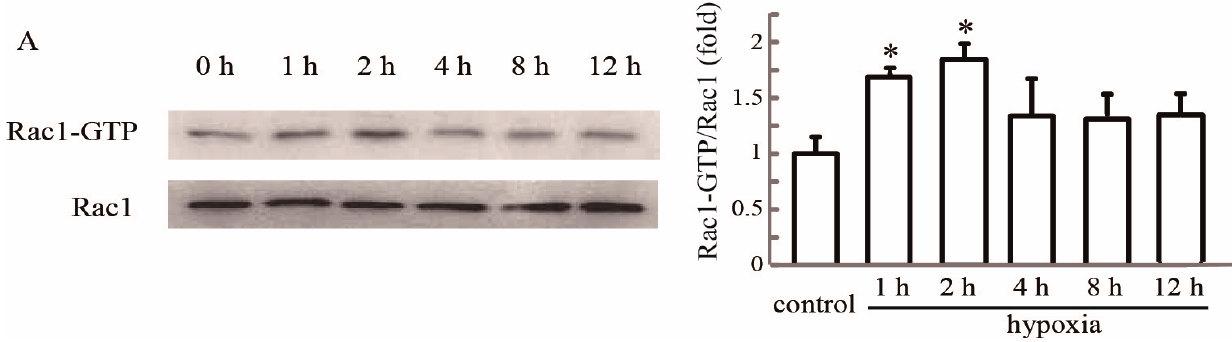
Figure 2. Melatonin inhibits hypoxia-induced Rac1 activation. ( A ) The effect of hypoxia on Rac1 activation. HUVECs were incubated under normoxia or hypoxia for the indicated periods, and cellular lysates were assayed for active Rac1 by pull-down assay; ( B , C ) The effect of melatonin on hypoxia-induced Rac1 activation. After treatment with melatonin at the indicated concentrations, cells were exposed to hypoxia for 2 h and then analyzed for Rac1 activation. * p < 0.05, referring to the difference between cells treated with and without hypoxia; # p < 0.05, ## p < 0.01, referring to the difference between cells treated with melatonin and hypoxia relative to the cultures exposed to hypoxia alone; and ( D ) The inactive mutant of Rac1-T17N inhibited hypoxia-mediated migration. Cells transfected with an empty vector or Rac1-T17N were grown under hypoxia for 24 h, and the cell migration rate was determined by the wound healing assay. * p < 0.05, referring to the difference between cells treated with and without hypoxia; # p < 0.05, referring to the difference between hypoxic cells transfected with Rac1-T17N and empty